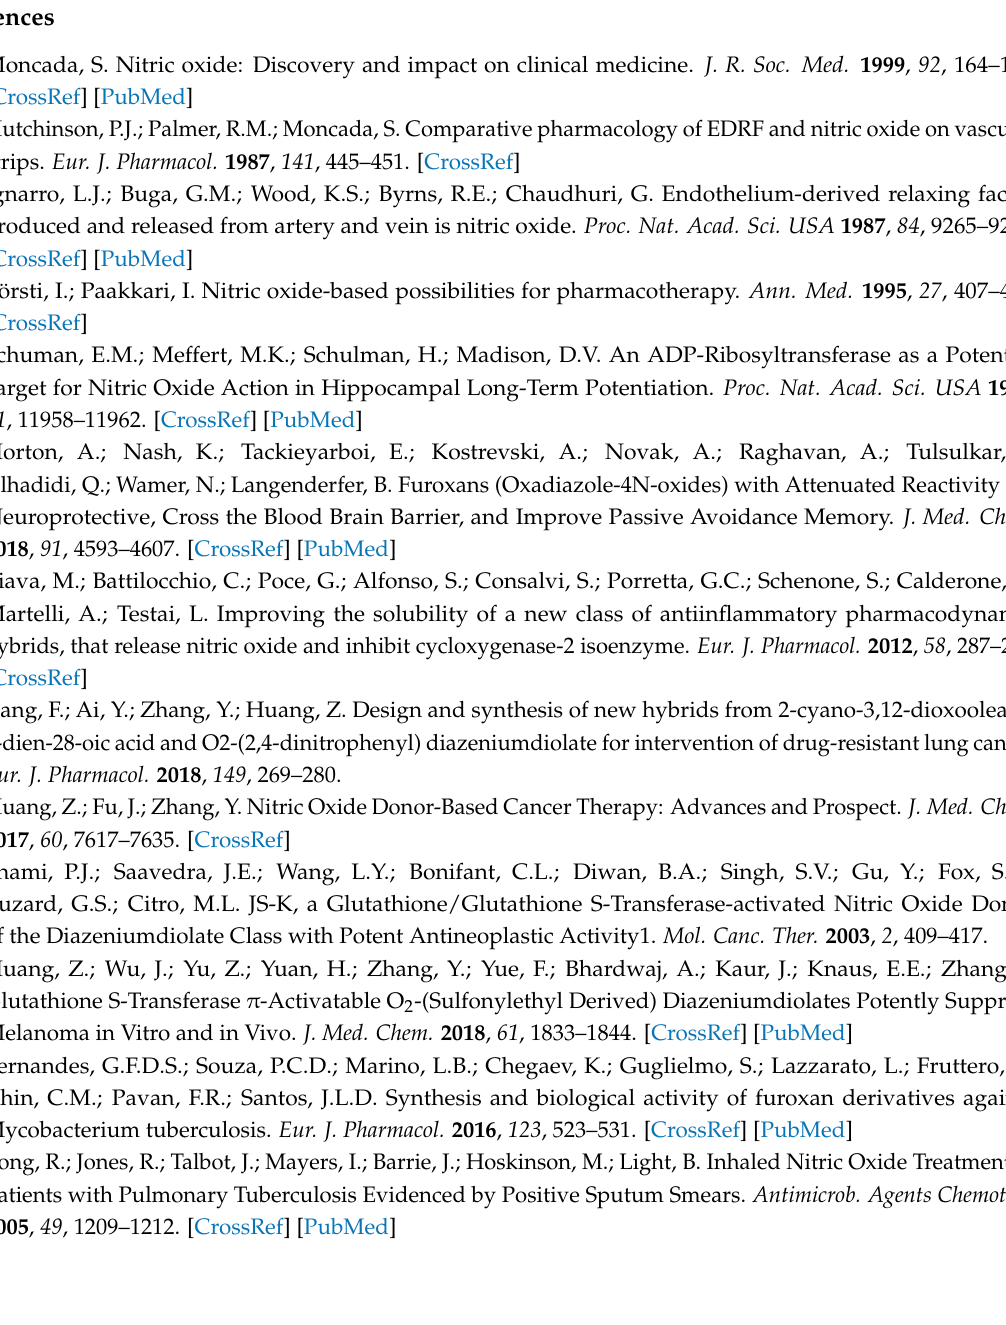
Supplementary Materials: The following are available online, 1 H- and 13 C-NMR spectra for all tatgeted compounds and 7a, 7b, 8, 9a, 9b. IR spectra for all tatgeted compounds and 8, 9a, 9b. Figure S1: The inhibitory effect of nitrates derivatives on the contraction induced by phenylephrine in mesenteric artery rings. Figure S2: The inhibitory effect of nitrates derivatives on the contraction induced by KCl in mesenteric artery